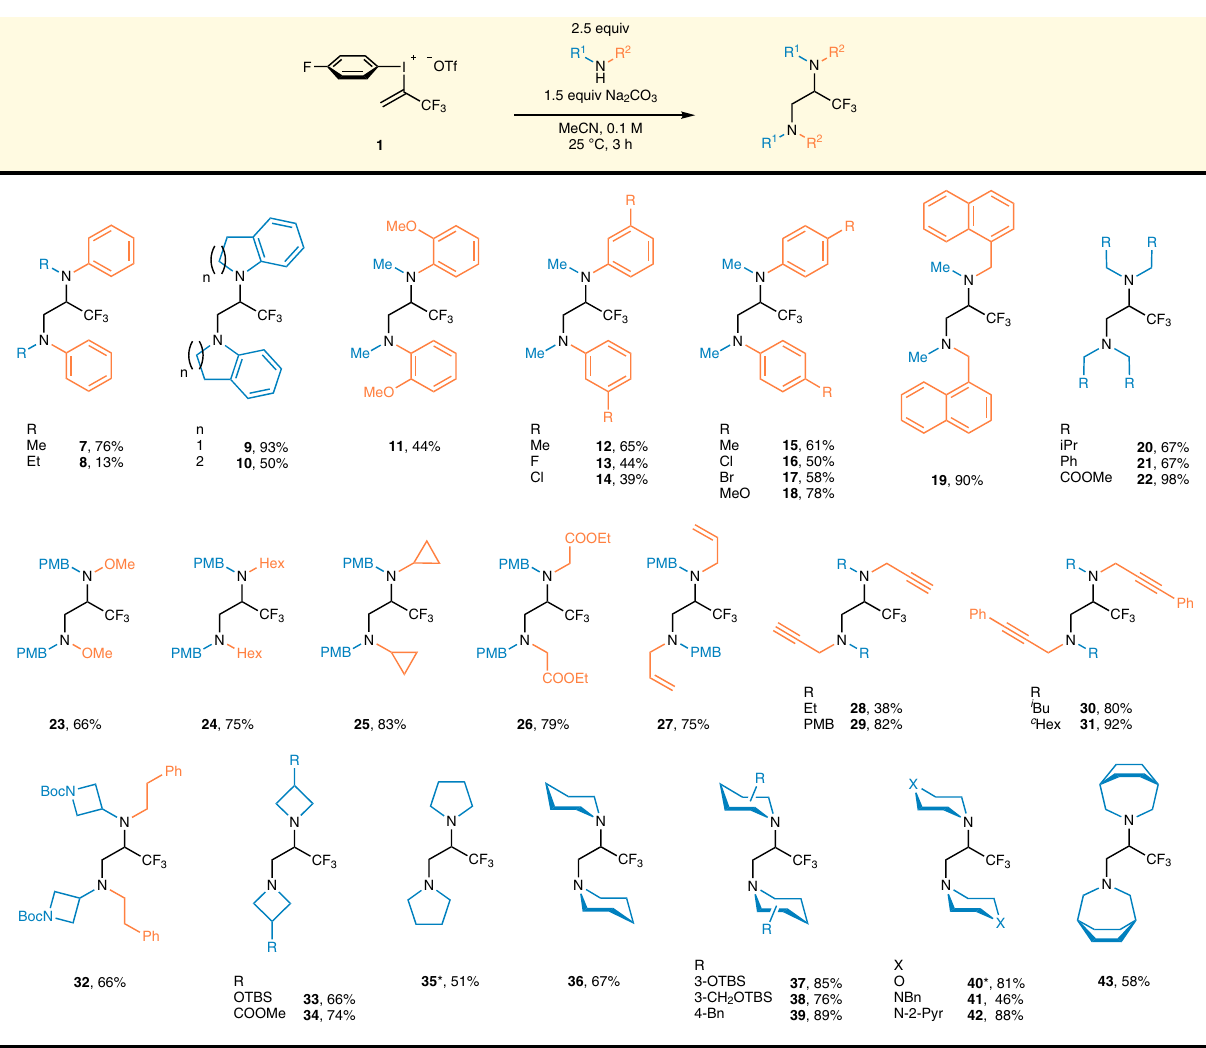
Fig. 3 Scope of the homofunctionalized diamine synthesis. 1 (0.2 – 0.3 mmol), R 1 R 2 NH (2.5 equiv.), Na 2 CO 3 (1.5 equiv.), MeCN, c = 0.1 M, 25 °C, 3 h. *Isolated as the corresponding bis(ammonium) tri fl uoroacetate salt (2 moles of tri fl uoroacetate ion per mole